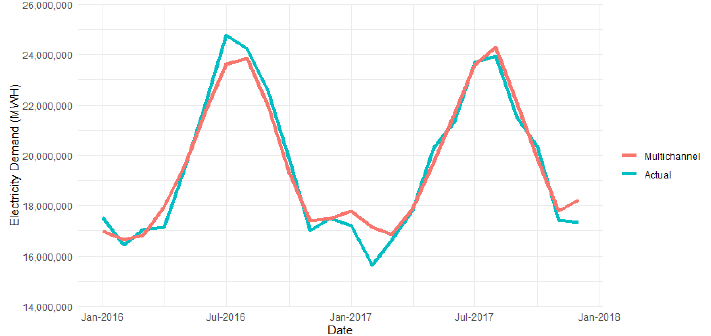
Figure 10. Actual vs. predicted multichannel CNN.